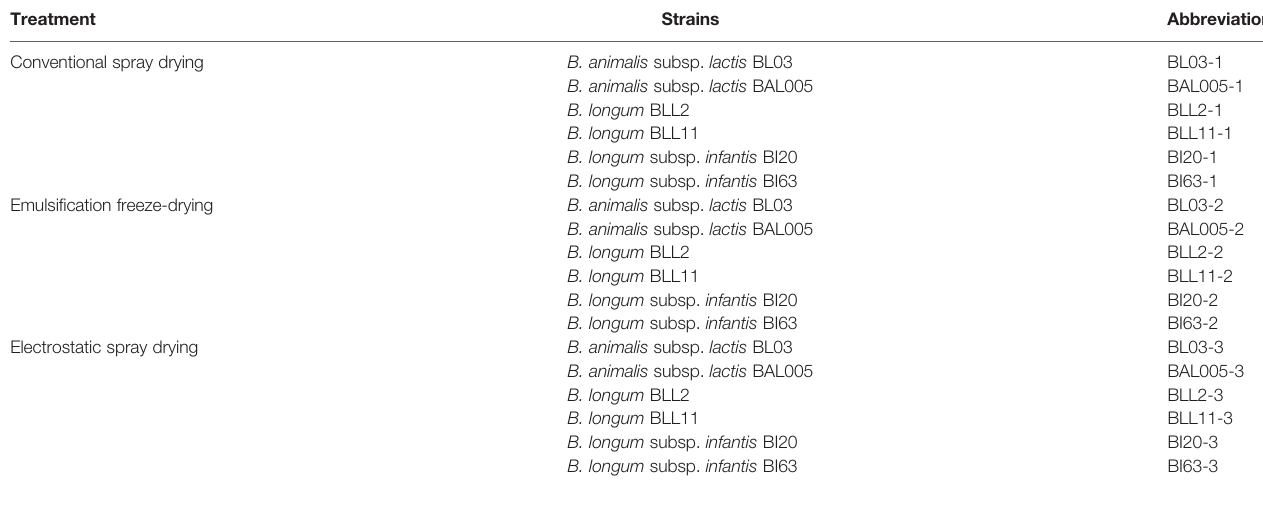
TABLE 1 | The speci fi c information of the experimental